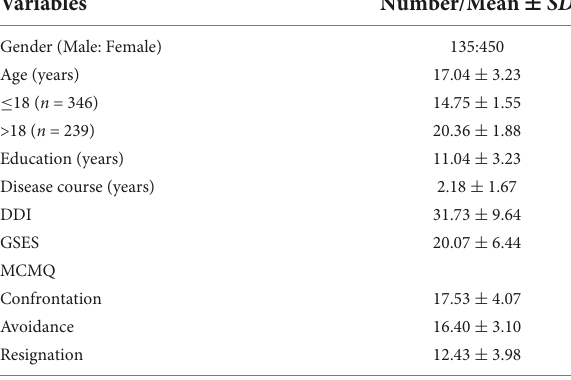
FIGURE1 Path model for the mediation effect of self-efficacy on the influence of self-disclosure on medical coping strategy of adolescents with depression.